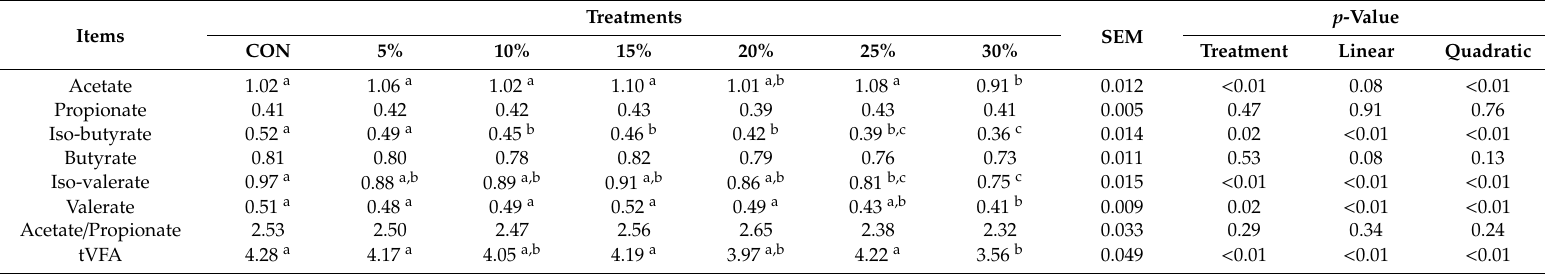
Table 8. Effectsofdifferentcassavaresiduesubstitutionratioforcrushedmaizeonin vitroVFAconcentrationaftercultivatingfor48hindairycowsatmid-lactation(mmol /